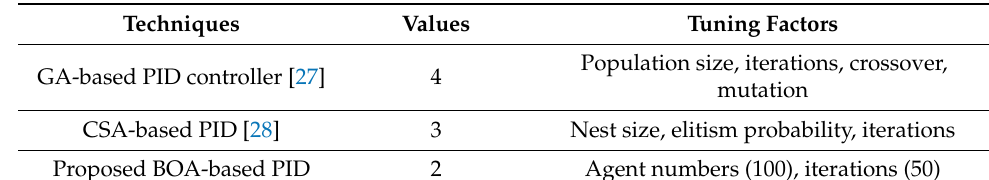
Table 3. Adjusted settings for various techniques.